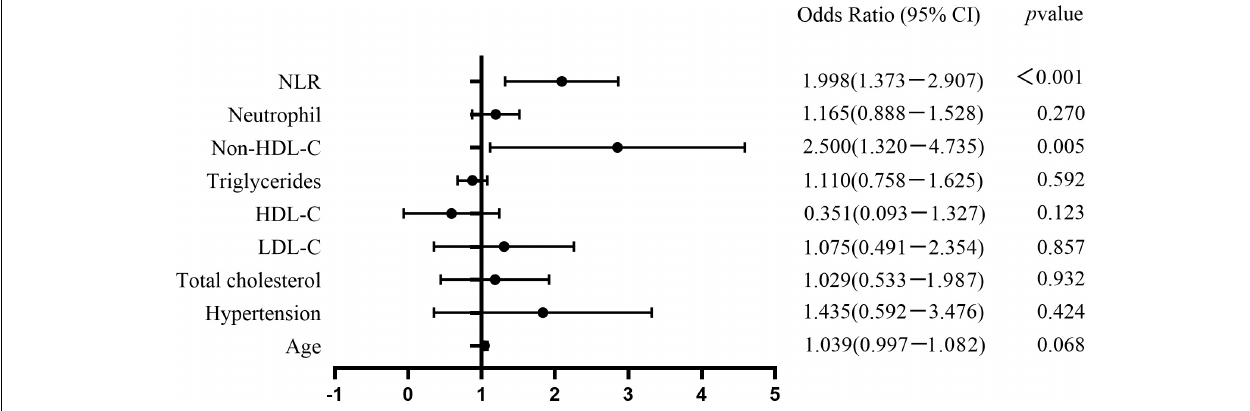
and the area under the ROC curve (AUC) were used to evaluate the predictive value. A P -value < 0.05 was considered to indicate statistical